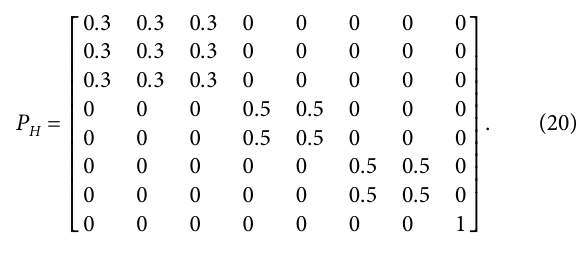
FIGURE 12 | Time evolution diagram of x